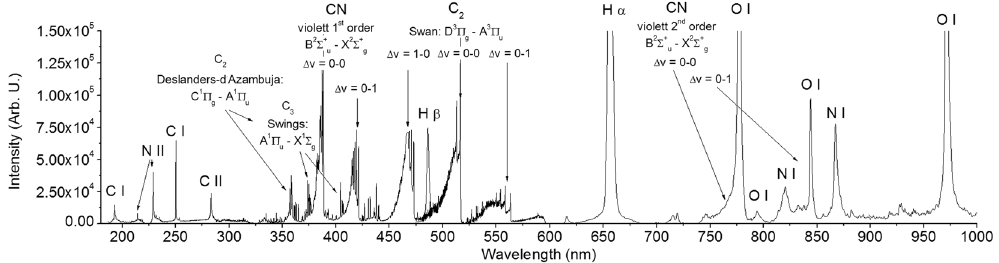
Figure 1. Compiled emission spectrum of laser induced breakdown in mixture of C, H, O & N bearing molecules 12,33,34,58